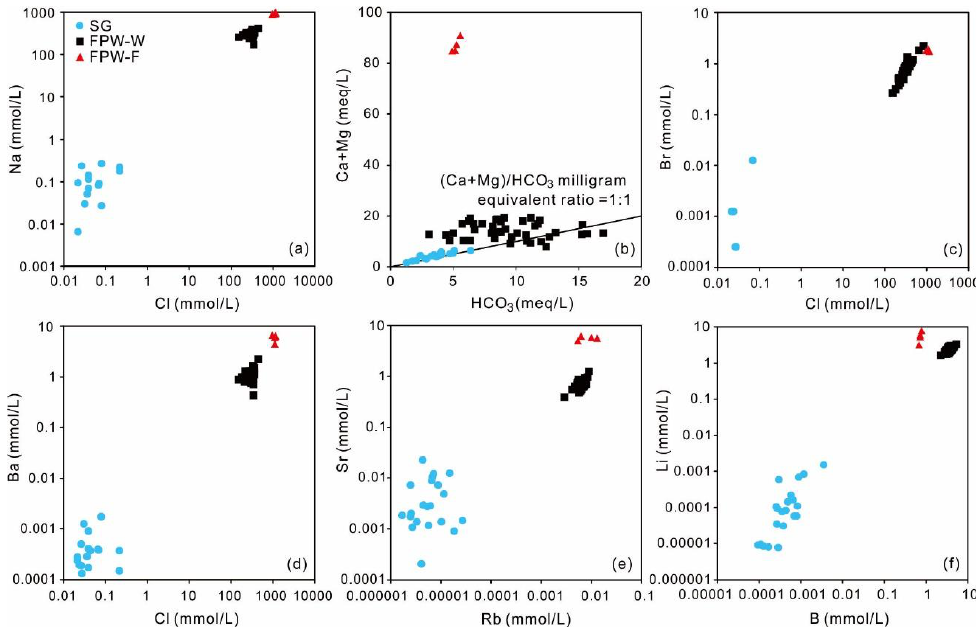
Figure 3. ( a ) Relationship between Na and Cl; ( b ) relationship between Ca + Mg and HCO 3 ; ( c ) relationship between Br and Cl; ( d ) relationship between Ba and Cl; ( e ) relationship between Sr and Rb; ( f ) relationship between Li and B. Rb; ( f ) relationship between Li and